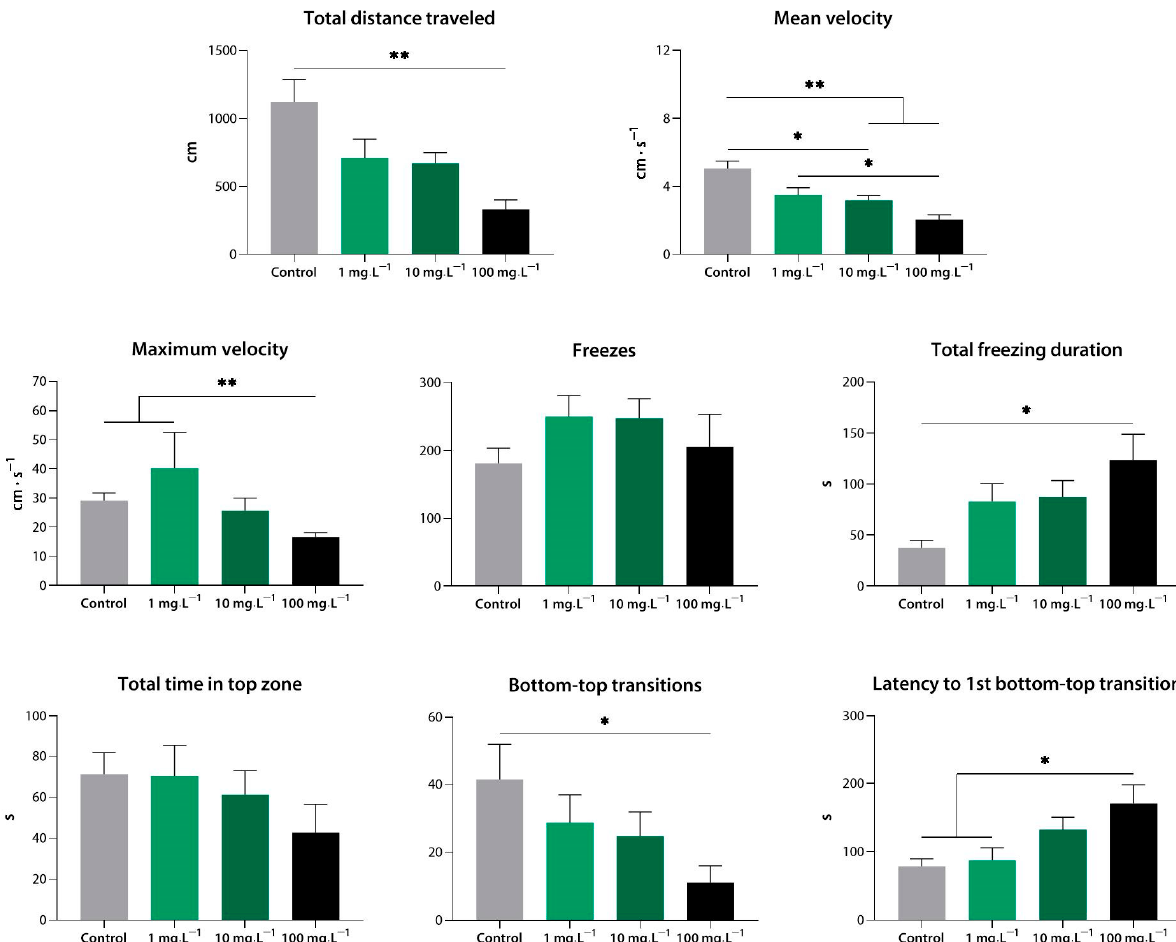
Figure 4. Compound 1 ( 9l ) induces sedation in zebrafish at a range of concentrations, as assessed using the novel tank test. *, p < 0.05; **, p < 0.01.